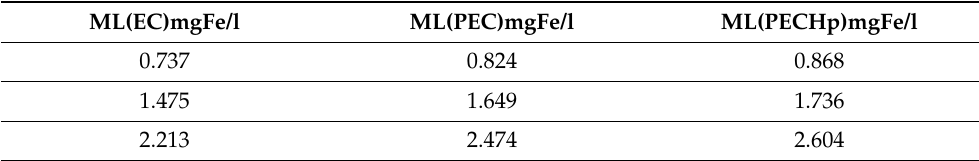
Table 4. The effect of metal loading on the removal of